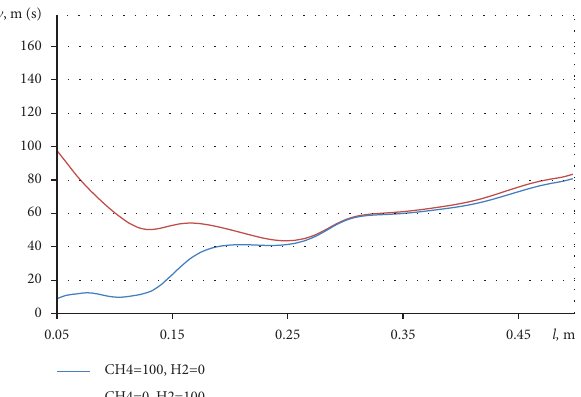
Figure 8: Change in the working fuid velocity along the fame tube axis with a hydrogen content of 0 and 100%.